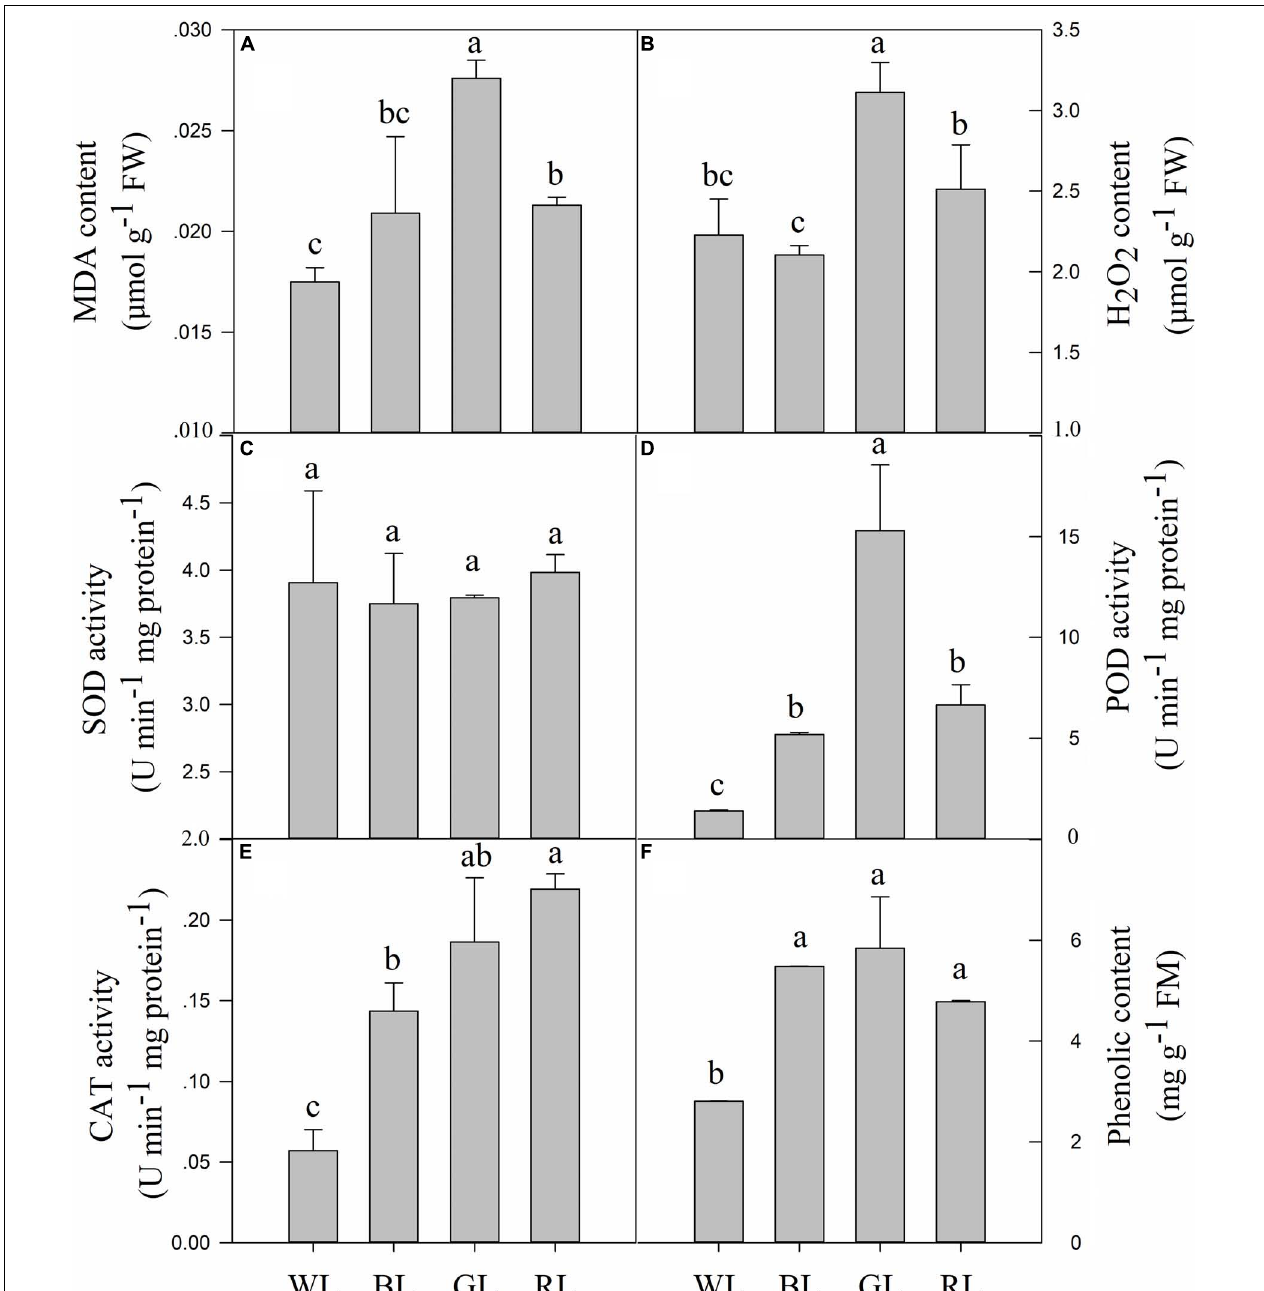
FIGURE 7 | Effects of light quality on MDA content (A) , H 2 O 2 content (B) , SOD activity (C) , POD activity (D) , CAT activity (E) and phenolic content (F) in C. paliurus leaves (Means ± SD). Different letters indicate significant differences ( P < 0.05) between LED light treatments according to ANOVA and LSD test, n = 3.